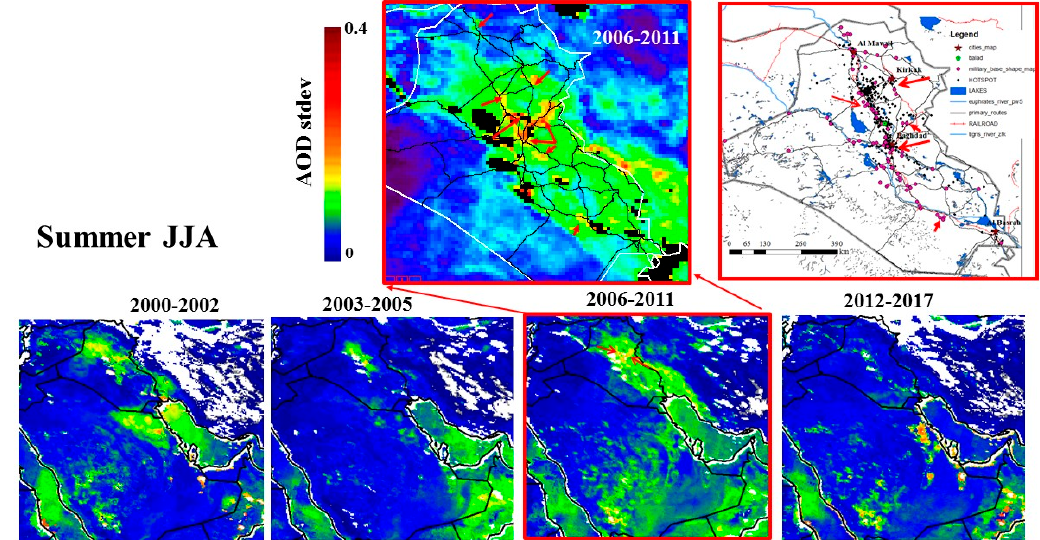
Figure 9. Average stdev of AOD in summer for different periods. We see an increase in AOD stdev in all areas indicated by red arrows (zoom-in on 2006–2011). These are areas with high anthropogenic activity. The stdev of AOD during 2006–2011 is also much larger than during the other reference periods.